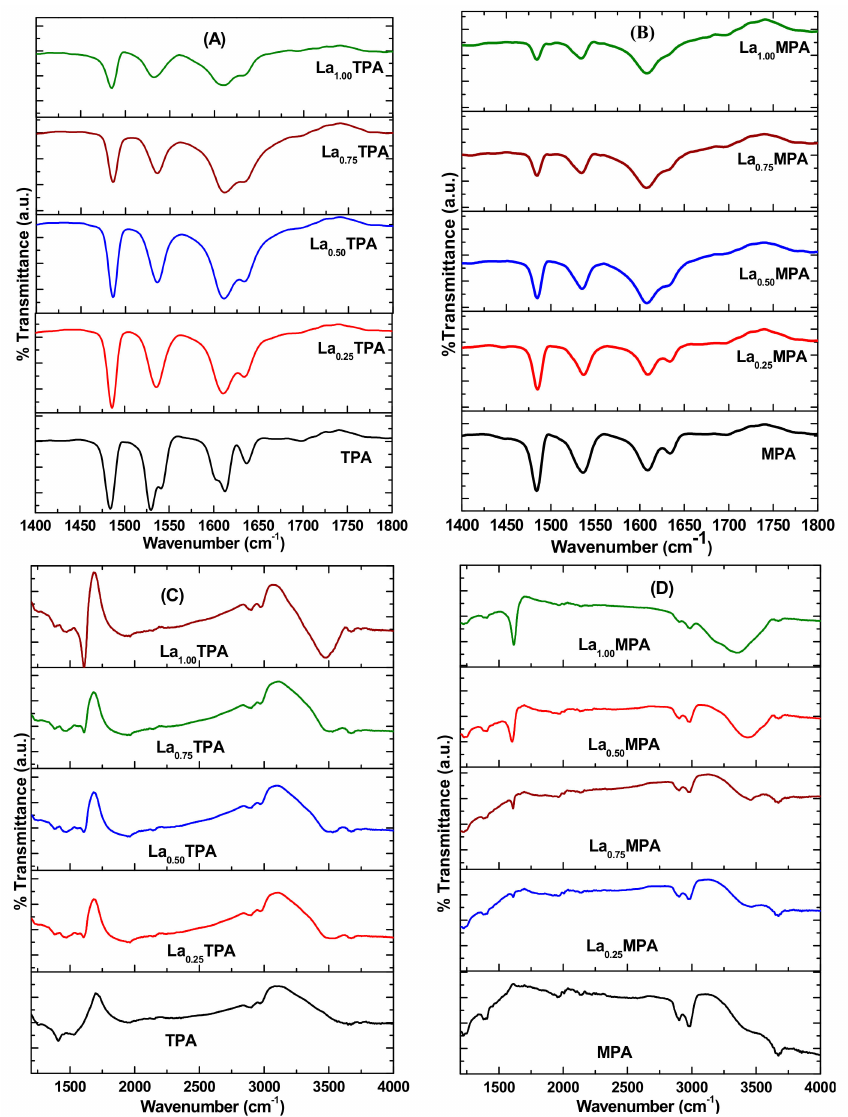
Figure 5. Acidity and basicity measurements using probe molecules and FTIR spectroscopy: ( A , B )-pyridine adsorbed samples, ( C , D )-pyrrole adsorbed samples. Transesterification of glyceryl tributyrate with methanol is a reversible chemical reaction